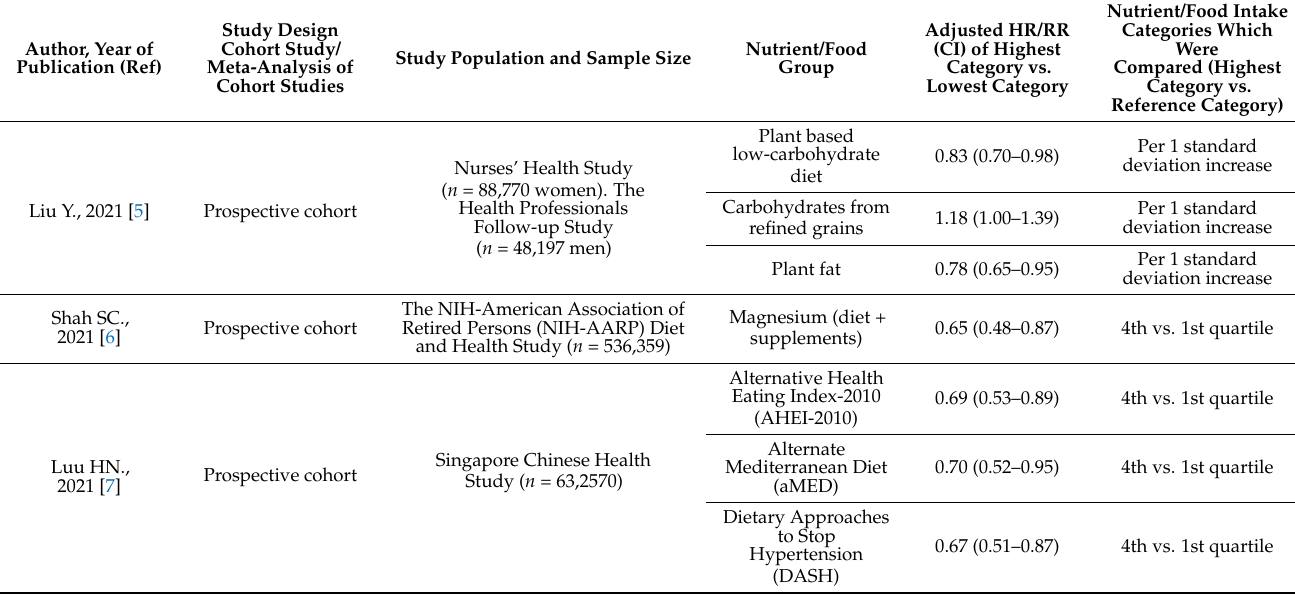
Table 1. Prospective cohort studies and meta-analyses of cohort studies testing the association between dietary factors and patterns and hepatocellular